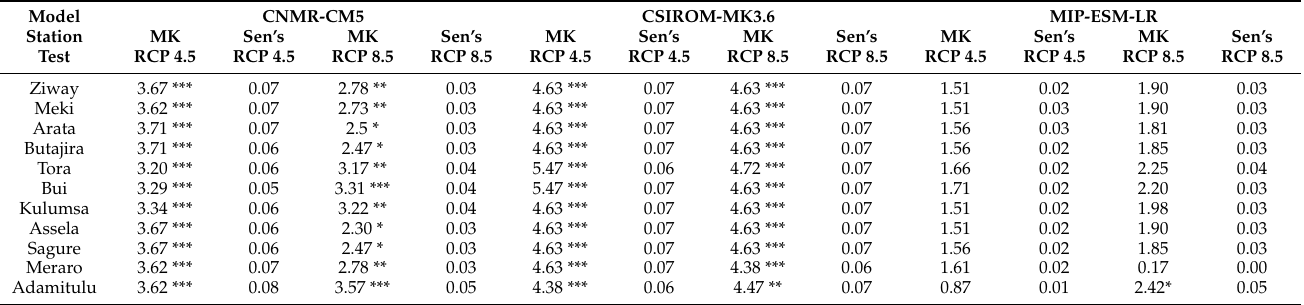
Table A9. Projected Mann–Kendall trend and Sen’s slope estimator results of annual mean T max for 11 stations over Ziway Lake Basin from the period